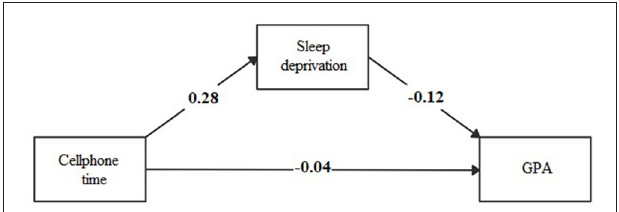
FIGURE 2 | Mediation model of sleep deprivation in the association between time spent during weekdays playing video games and academic performance